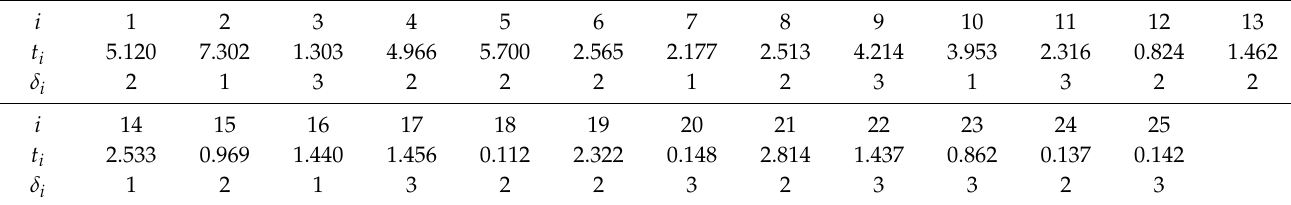
Figure 1. Empirical cumulative distribution plot, Q-Q and P-P plots for the exponential, Pareto and Rayleigh distribution under AIDSSI data . Table 12. MinRSSU samples of HIV infection competing risks